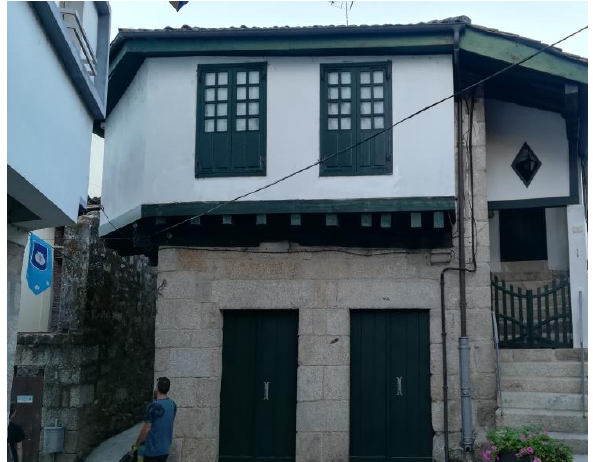
Figure 9. Half-timbered house filled with earth filling in the city of Ribadavia. Source: A.F.P.